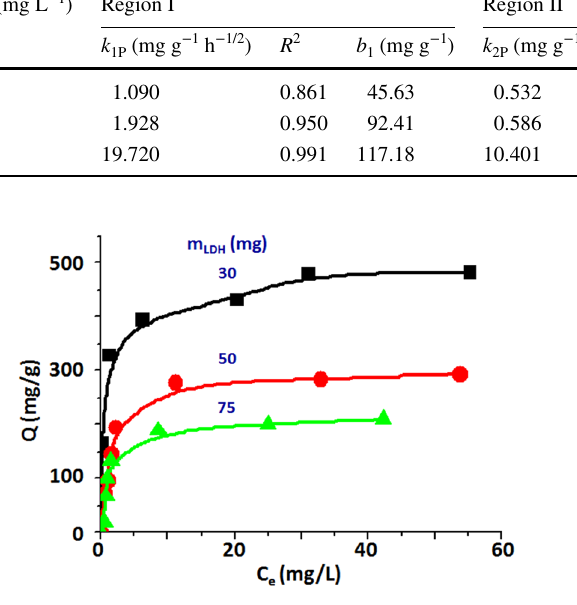
Fig. 6 Adsorption isotherms for AG1 determined with three different sorbing doses (30, 50 and 75